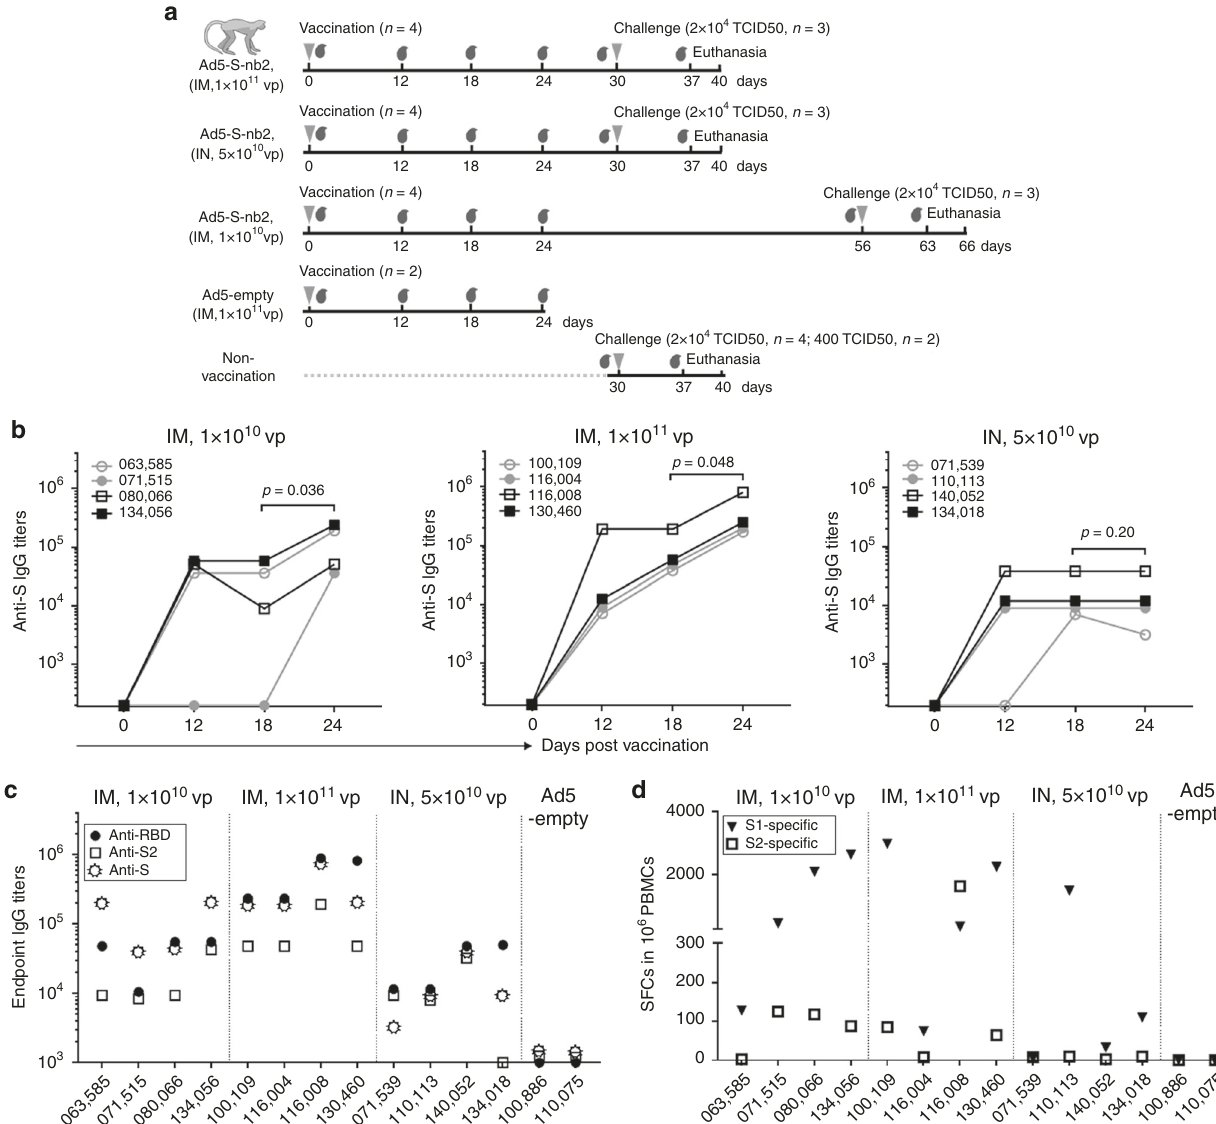
Fig. 3 The immunogenicity of Ad5-S-nb2 in Chinese rhesus macaques. a Schematic diagram of the vaccination and challenge studies in rhesus macaques. Three groups of macaques ( n = 4 per group) were vaccinated via an IM injection of 1 × 10 10 vp or 1 × 10 11 vp Ad5-S-nb2 or via an IN and oral inoculation of 5 × 10 10 vp Ad5-S-nb2 each. The control groups include macaques ( n = 2) IM injected with 1 × 10 11 vp Ad5-empty and non-vaccinated macaques ( n = 6). On days 0, 12, 18, and 24 after vaccination, the serum samples and PBMCs were collected. On day 30 (Group 1 and 2) or 56 (Group 3) after vaccination, macaques were challenged. On day 7 or 10 after challenge, macaques were euthanatized. The gray inverted triangles indicate the time points of vaccination or challenge, whereas the gray blood drop symbols indicate the time points at which the serum samples were collected. b The kinetics of IgG response to the S protein in the sera. The endpoint IgG titers are shown. The overlapped data points represent the same values. Comparisons between different time points were performed by Student ’ s t -test (paired, one-tailed). c The antigen recognition pro fi les of macaque immune sera. Macaque immune sera collected on day 24 were assessed for the IgG antibodies against the RBD, S2, and S protein by enzyme-linked immunosorbent assay (ELISA). d IFN- γ - secreting cells in the PBMCs of rhesus macaques. PBMCs isolated on day 18 were stimulated with two peptide pools corresponding to S1 and S2, respectively. Shown are the number of SFCs in one million PBMCs. All the data points represent the mean values of two technical replicates. Source data are provided as a Source Data fi